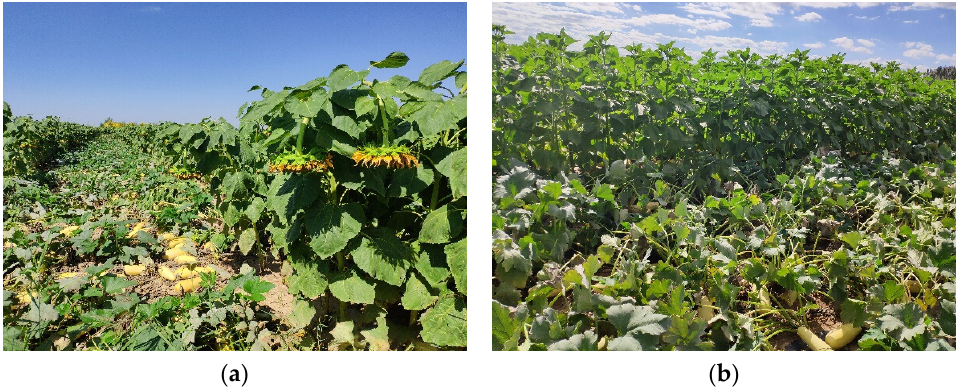
Figure 11. The on-site images of zucchinis intercropped with sunflowers: ( a ) the angle from the front;